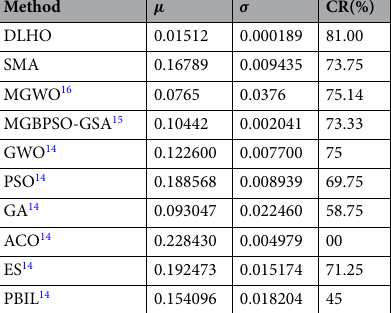
Table 15. Algorithms outcomes for the Heart database.